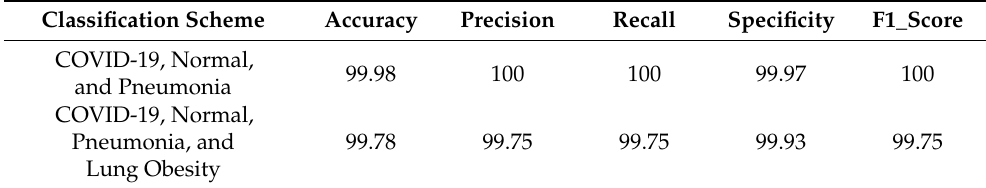
Table 6. Performance evaluation on COVID-19 Radiography Database multi-class